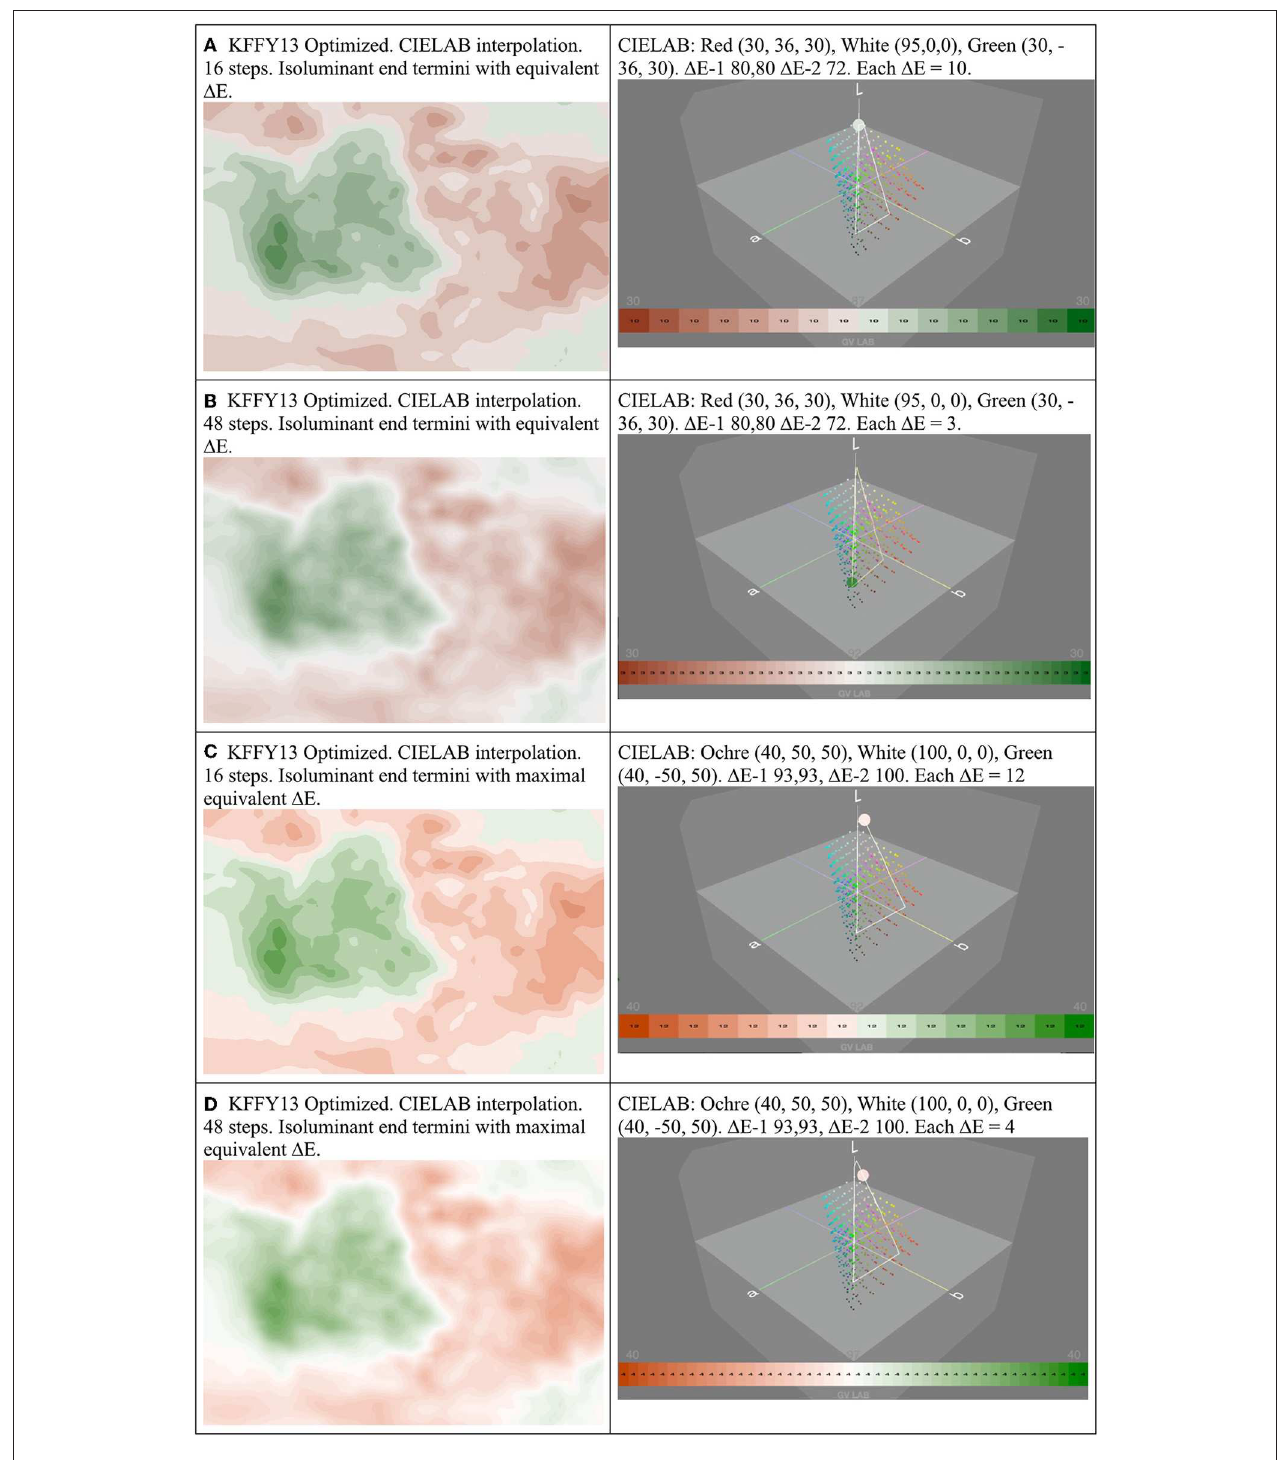
FIGURE 5 | Comparative optimized visualizations generated using the Gradient Designer and LAB Color Mixer Apps (left column) shown with supporting insights in CIELAB color space provided through the GV_LAB App (right column). For details of the grid values being displayed, see the caption for Figure 4 . (A) KFFY13 optimized, 16 step divergent color-map, with isoluminant termini with equivalent 1 E from termini to midpoint; (B) As per B, with 48 steps; (C) 16 step divergent color-map, with isoluminant termini with enlarged 1 E from termini to midpoint, enlarged 1 E between termini; (D) As per (C) , with 48 steps. CIELAB colorspace conversions use D 65 2 ◦ illuminant. Red-Green termini may present difficulties for viewers with deuteranopia, tritanopia. High resolution: https://doi.org/10.5281/ zenodo.3264037.